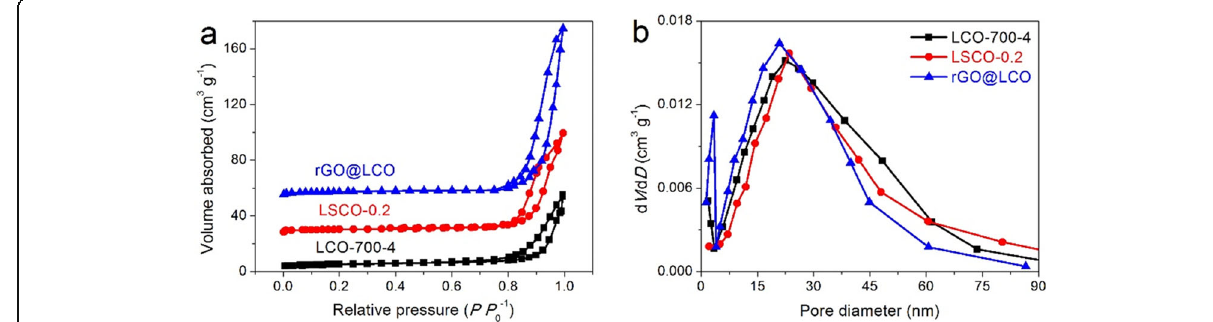
Fig. 5 a Nitrogen adsorption-desorption isotherms and b the corresponding pore size distribution curves of LCO-700-4, LSCO-0.2, and